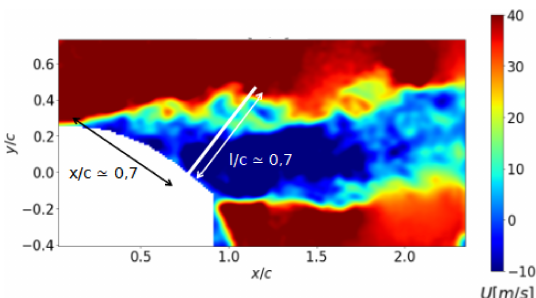
Figure 13. First method to detect the flow stall–reattachment in- stants: location and direction of integration line used to compute U norm ( t ) (i.e. white bar on the blade) reported on isocontours of the velocity modulus from PIV measurements.